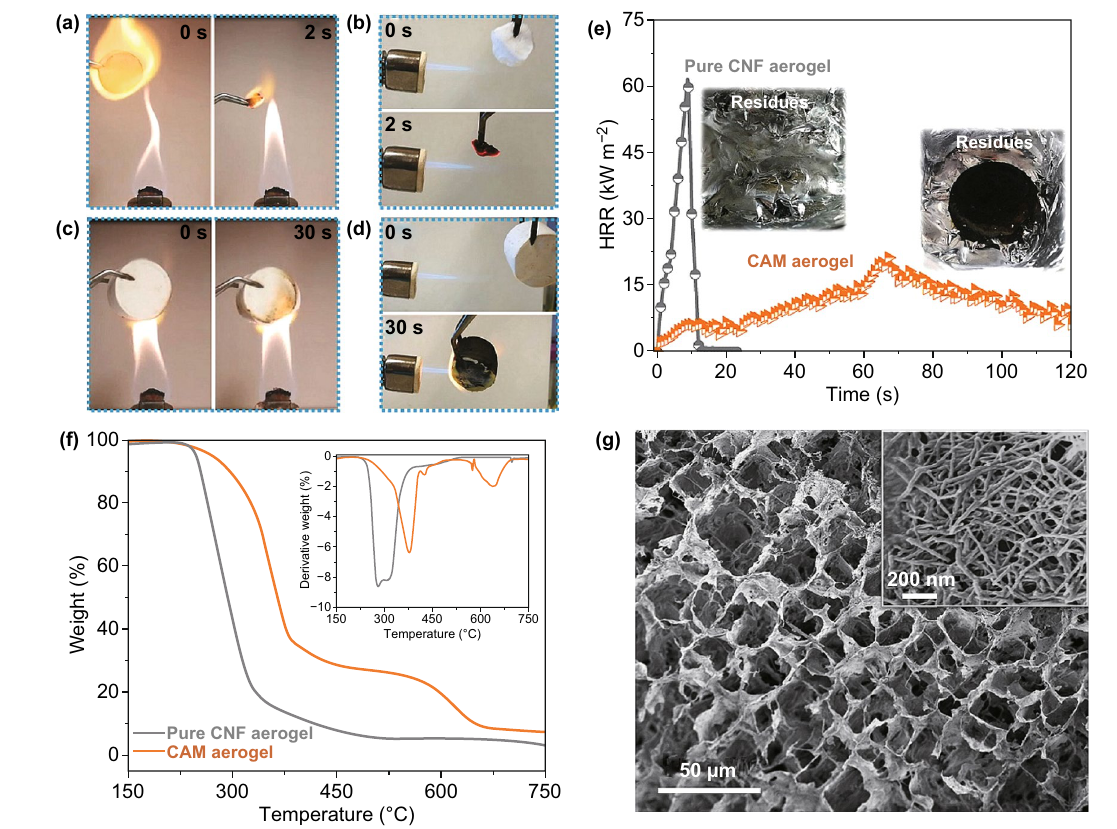
Fig. 5 Burning tests of a the pure cellulose nanofiber (CNF) aerogel in the flame of an alcohol lamp (~ 500 °C), b the pure CNF aerogel in the flame of a butane blowtorch (~ 1300 °C), c CNF@Al‑MIL‑53 (CAM) aerogel in the flame of an alcohol lamp, and d CAM aerogel in the flame of a butane blowtorch. e Heat release rate (HRR) curves of the pure CNF and CAM aerogels recorded during the cone calorimetry test. The insets show the residues after the measurements. f TGA analysis curves of the pure CNF and CAM aerogels under air flow. g High‑resolution SEM images of CAM aerogel after the combustion experiment in the flame of a butane